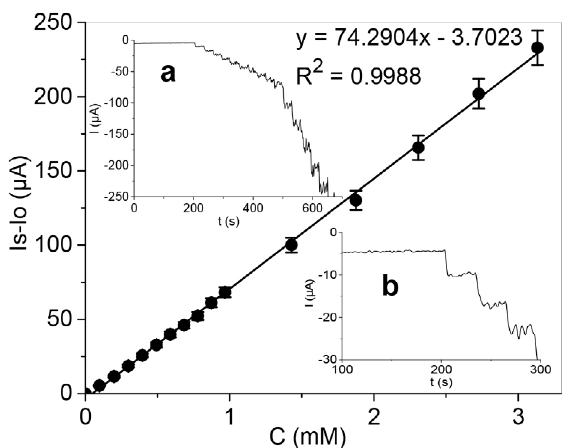
Fig. 5. Calibration plot of chronoamperometric currents vs. iodate concentration at an applied potential of 0.0 V; Insets: a) Authentic re- cord of the amperometric response of RuOHCF/GC in PBS (pH 1.0) for successive additions of iodate; b) The enlarged initial section of the amperometric curve (3 injections of 0.1 mM KIO 3 were added).